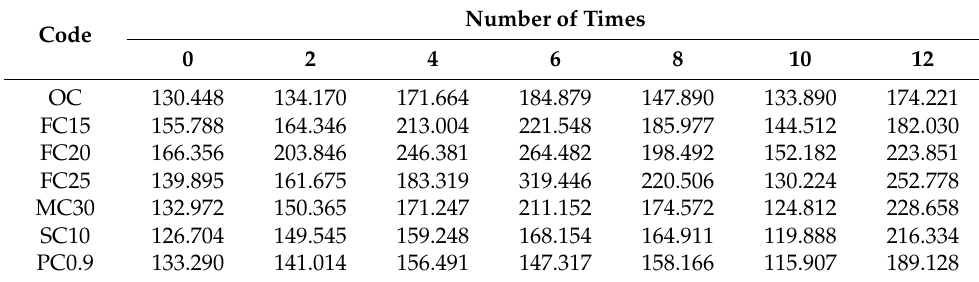
Table 8. Fracture energy of concrete expose to dry–wet